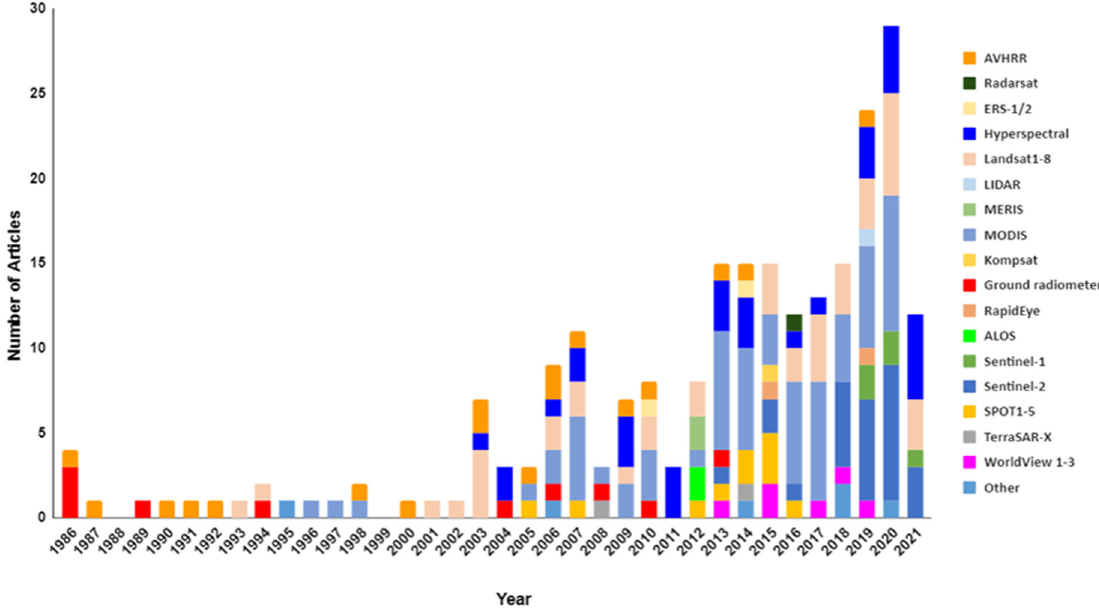
Figure 7. Temporal development of the remote-sensing systems used to analyze GP for the period between 1986 and the end of 2021.